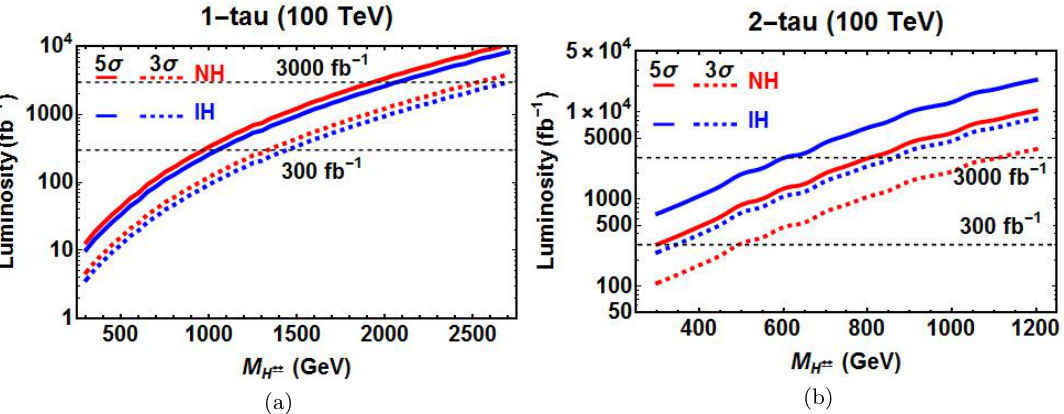
Figure 8 . Integrated luminosity versus M (cid:28) (cid:6) ‘ (cid:6) ‘ (cid:7) ‘ (cid:7) (a) and ‘ + (cid:28) + ‘ (cid:0) (cid:28) (cid:0) (b) with (cid:28) (cid:6) ! (cid:25) (cid:6) pp ! H ++ H (cid:0)(cid:0) ! (cid:28) (cid:6) ‘ (cid:6) ‘ (cid:7) ‘ (cid:7) ; ‘ + (cid:28) + ‘ (cid:0) (cid:28) (cid:0) , and leading SM backgrounds with (cid:28) (cid:6) ! (cid:25) (cid:6) (cid:23)